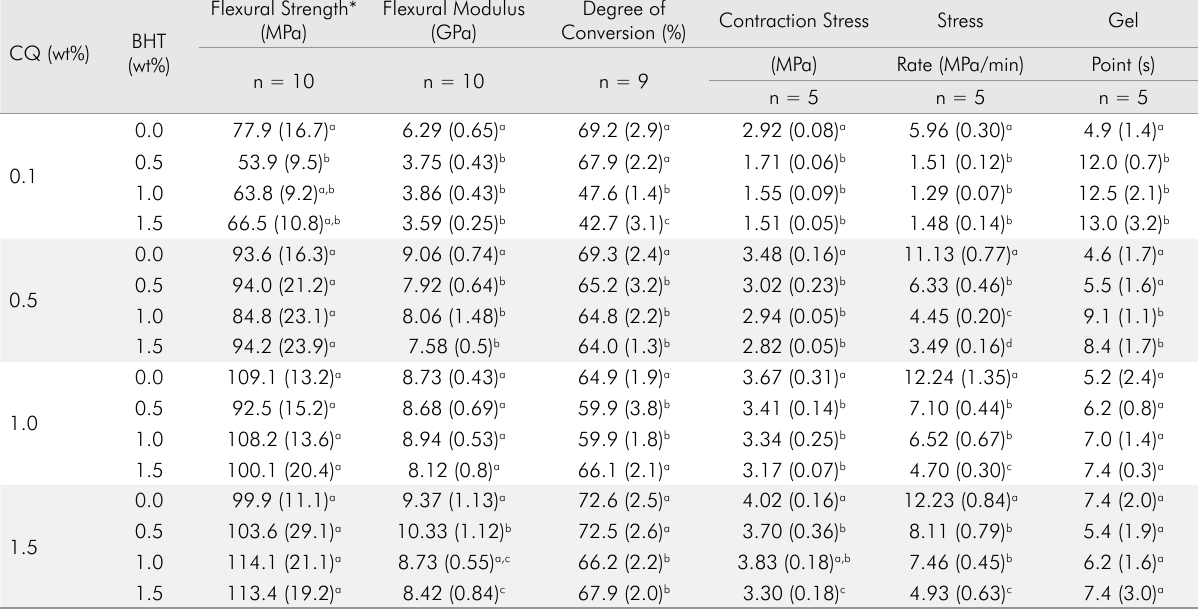
Table. Mean and standard deviation of the parameters tested with different camphorquinone (CQ) and butylhydroxytoluene (BHT) combinations, grouped based on CQ